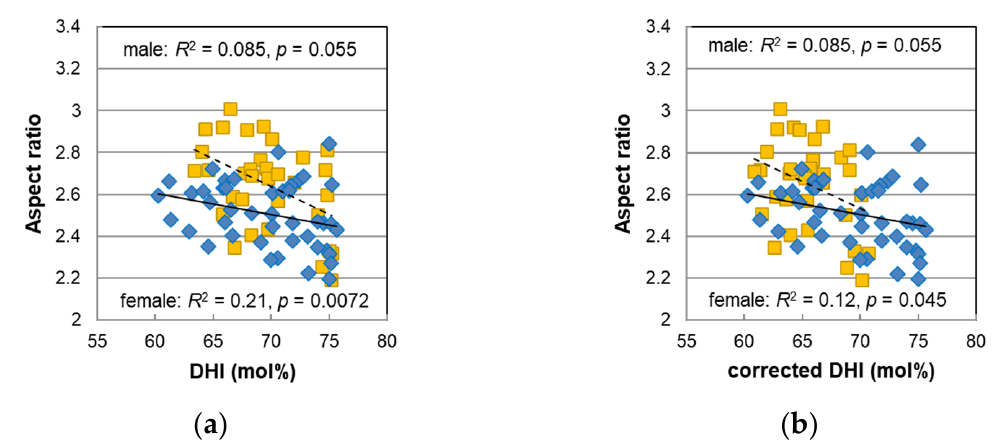
Figure 7. The relationship between the aspect ratio and DHI mol% for male (diamonds) and female (squares) pigmented hairs. The DHI mol% values for female hairs in ( a ) were cited from the original paper [14], and in ( b ), they were corrected assuming that they would be obtained in the improved HPLC condition (see text).